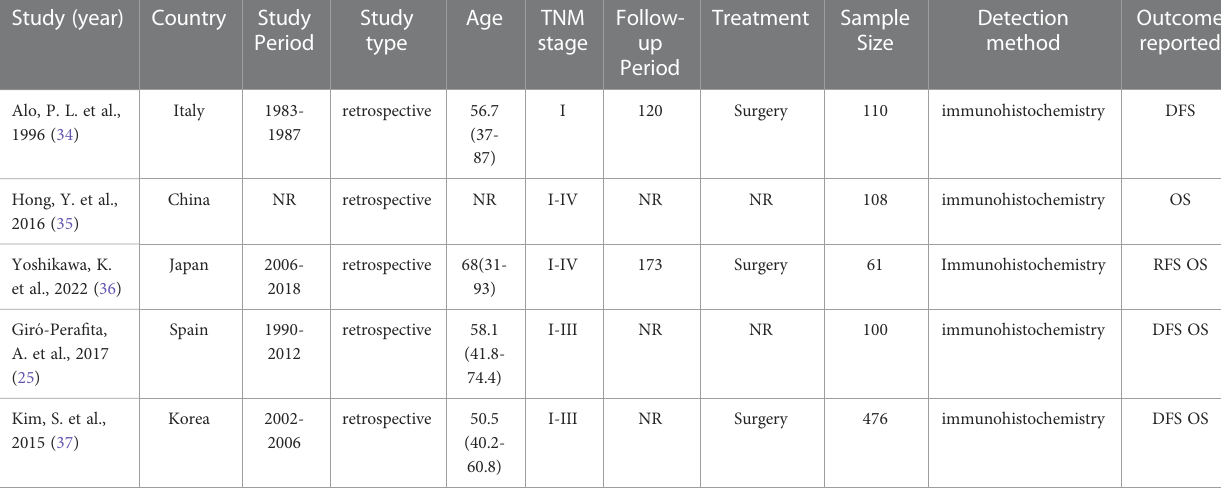
Table S3. The results of the pooled analysis demonstrated that